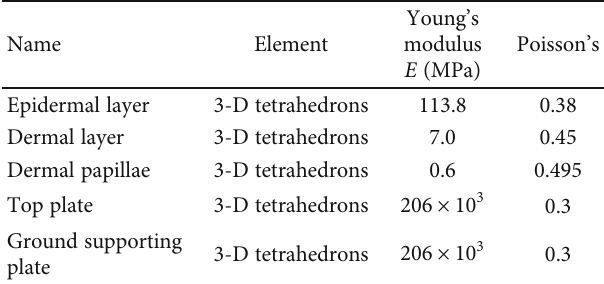
Figure 5: (a) Hoof bulb tissue assembly model, (b) dermal layer model, (c) dermal papilla model, (d) epidermal layer model, and (e) normal model. ① : top plate; ② : ground supporting plate. Table 1: Material properties and element types of the FEM model.